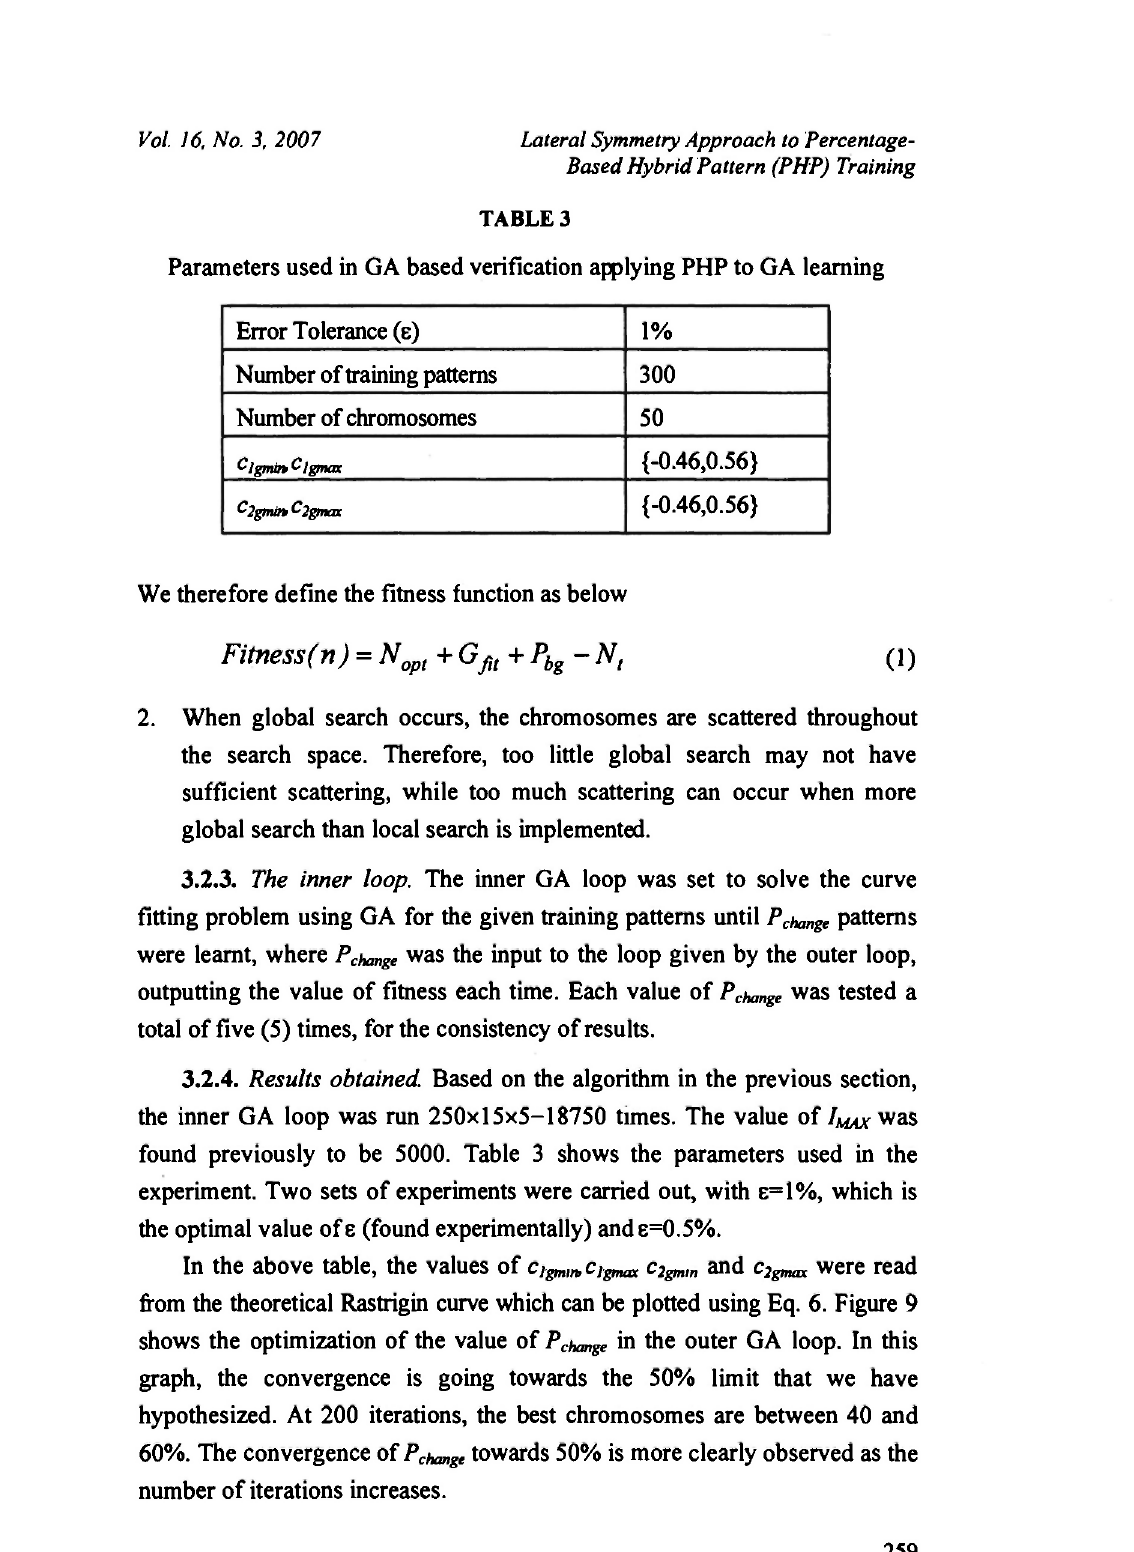
Parameters used in GA based verification applying PHP to GA